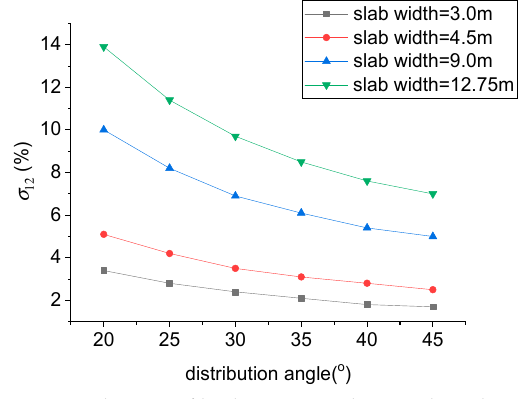
Figure 1. Comparison of prestress loss of BFRP tendons and steel strands in the prestressing stage at various slab widths and distribution angles (%).